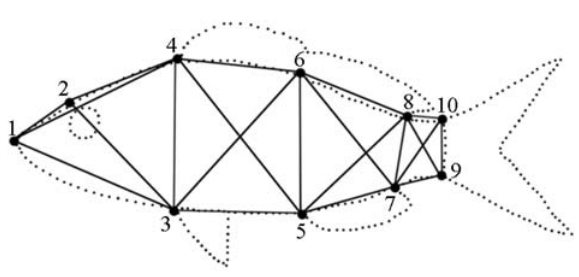
Figure 2 - Outline of Ocyurus chrysurus showing the 10 landmarks and the truss network of measured distances.